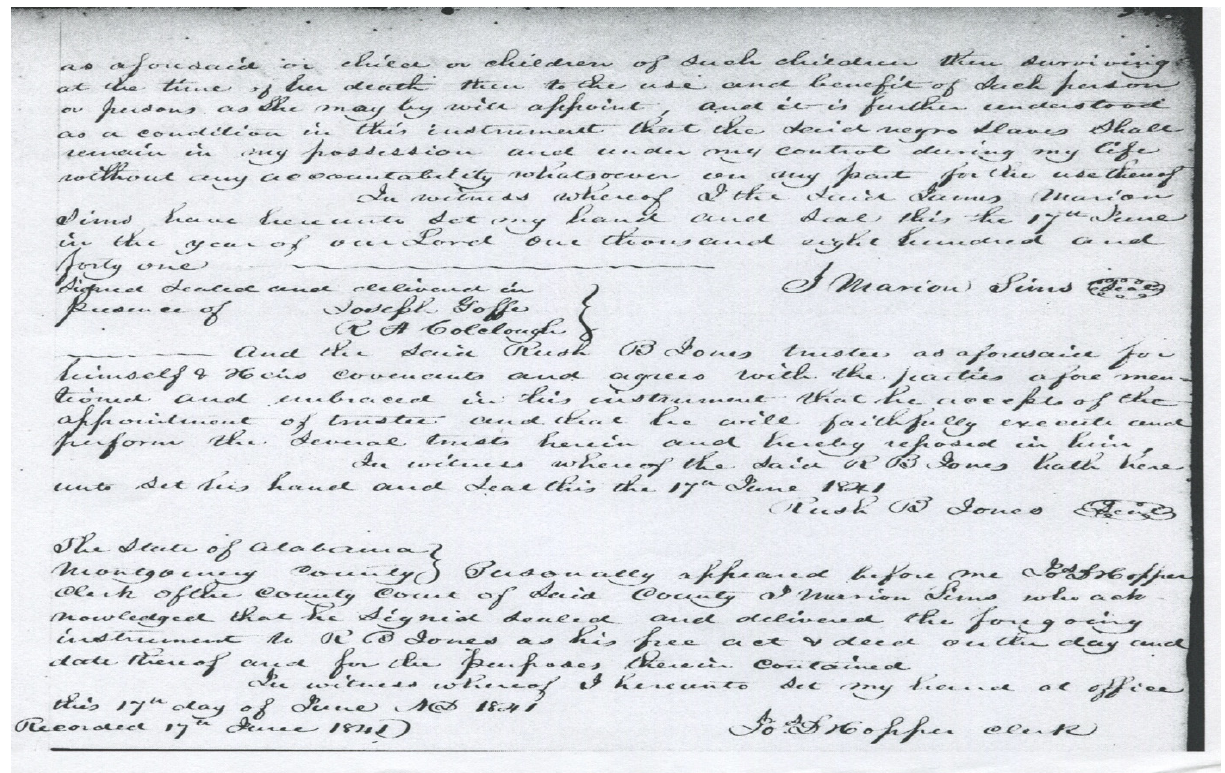
Figure 1. “James Marion Sims Property Deed to Rush B. Jones in trust for Theresa Sims” Montgomery, County 1841. Copyright of the Alabama Department of Archives and History.